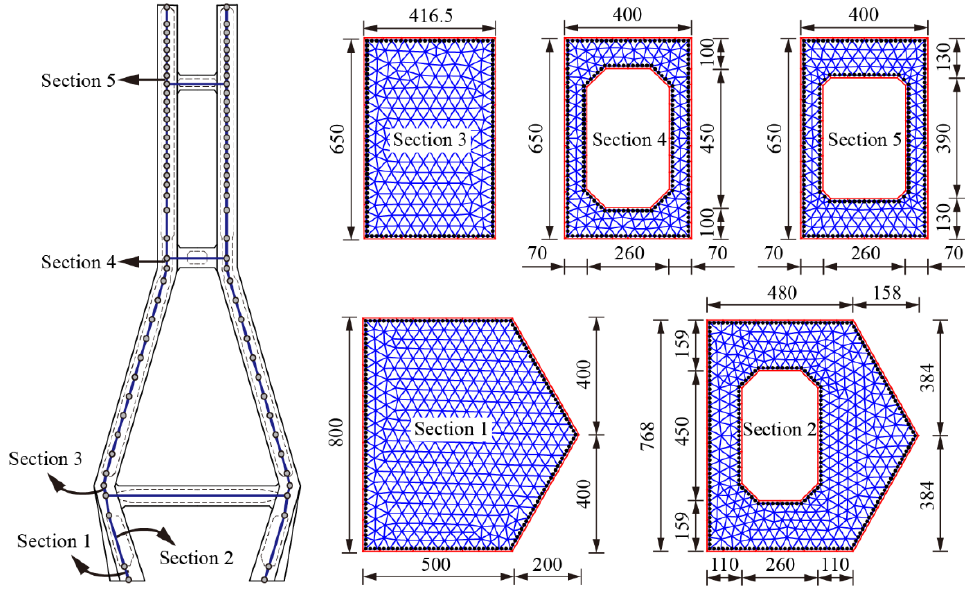
Figure 4. Fiber sections of the pylon (unit: cm).